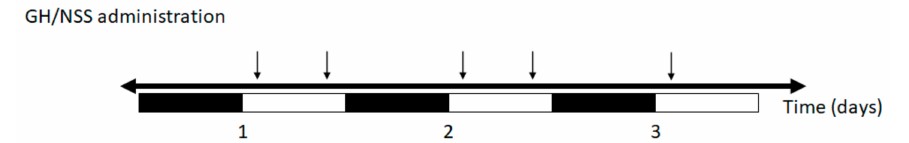
Figure 2. The rats in each group were treated with either GH or NSS for 3 days (short-term adminis- tration). The arrows indicate GH or NSS administration (0800h and 1600h). The black and white bars show dark and light phases, respectively (12 h/12